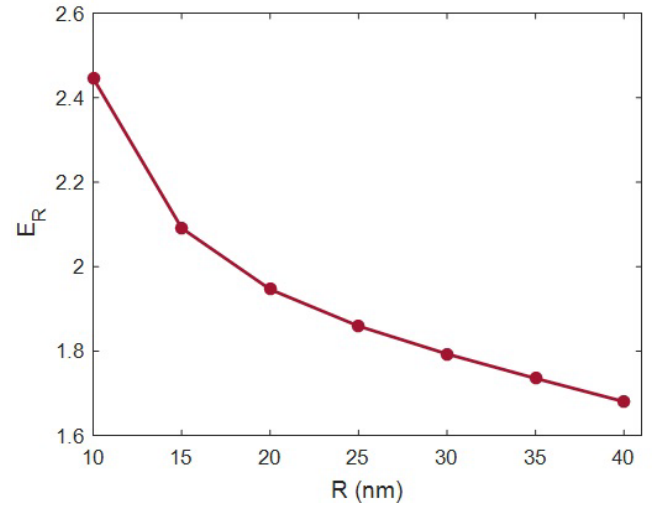
Figure 4. Influence of filler radius on the “ E R ”.